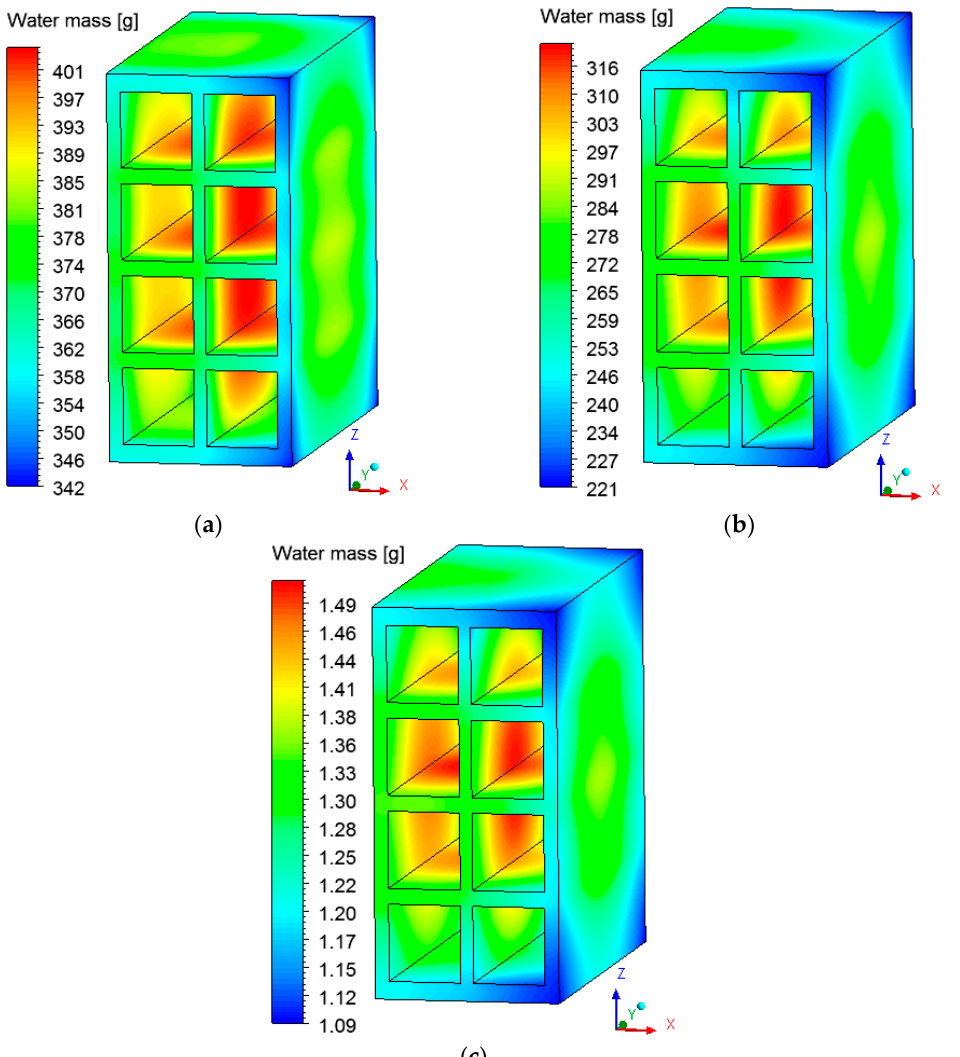
Figure 10. Water mass fields on the external surface of the brick at different moments of drying: ( a ) 10 min, ( b ) 60 min, and ( c ) 950 min.